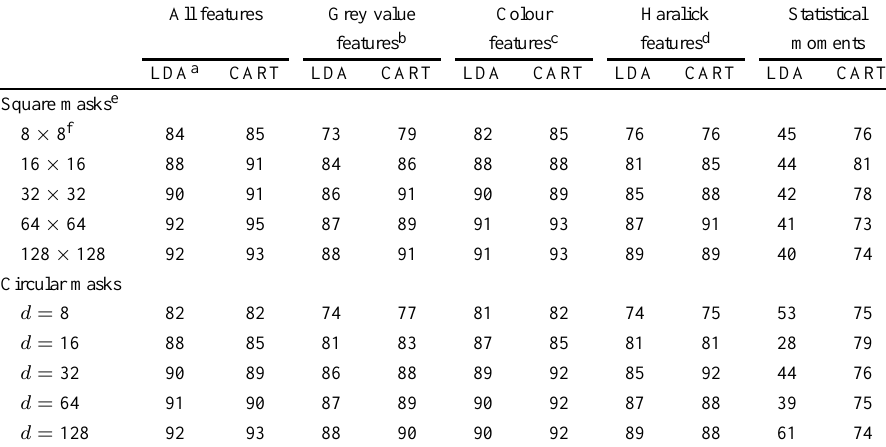
Percentage of correctly classified elements of melanoma tissue, other tissue components and background in haematoxylin–eosin-stained slides. Influence of image analysis features, size and shape of elements, and statisti- cal procedures ( n = 6000 elements per test; LDA: linear discriminant analysis; CART: classification and regres- sion tree). The best result was obtained with a 64 × 64 pixel square mask, using all features evaluated by